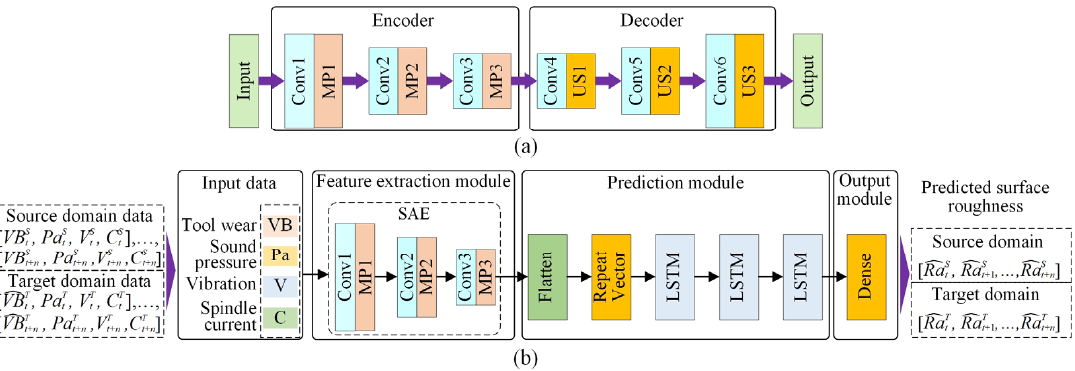
Figure 3. SAE and surface roughness prediction model structure based on SAE–LSTM: ( a ) SAE; ( b ) the surface roughness prediction model structure based on SAE-LSTM.